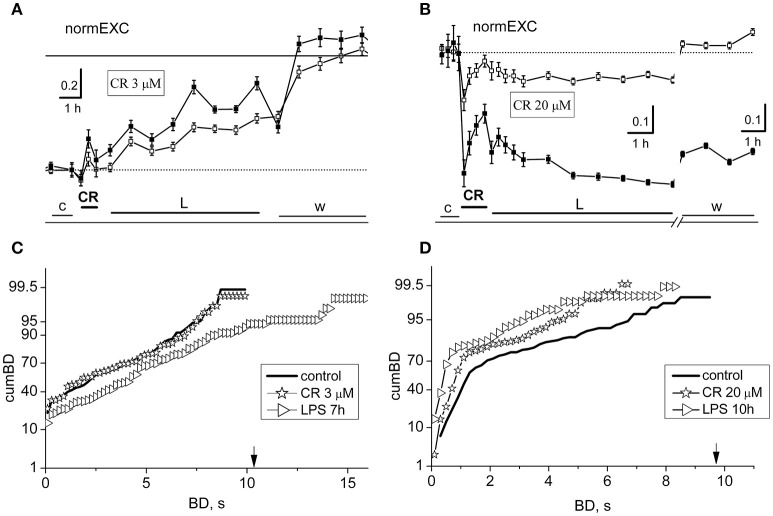
Short- and long-term effects of crocin (CR) in networks treated with LPS. Data in (A,C) and those in (B,D) belong to the same exemplary experiment. (A,B) Plots of normEXC data for two exemplary experiments in which the dishes were treated with crocin (CR) at 3 and 20 μM, respectively. Open and closed symbols indicate excitatory and inhibitory neurons. The continuous line is the fixed threshold. (C) Plot of cumBD in control (thick line), in the presence of 3 μM CR (asterisks), and during the seventh hour after the addition of LPS (3 μg/ml; right triangles). These two last curves were significantly different from the control curve with P < 0.05. (D) Plot of cumBD in control (thick line), in the presence of 20 μM CR (asterisks), and during the 10th h after the addition of LPS (right triangles). The vertical arrow indicates the fixed threshold. These last curves were significantly different from the control curve with P < 0.05. The highest dose of CR prevented the late excitatory LPS responses.